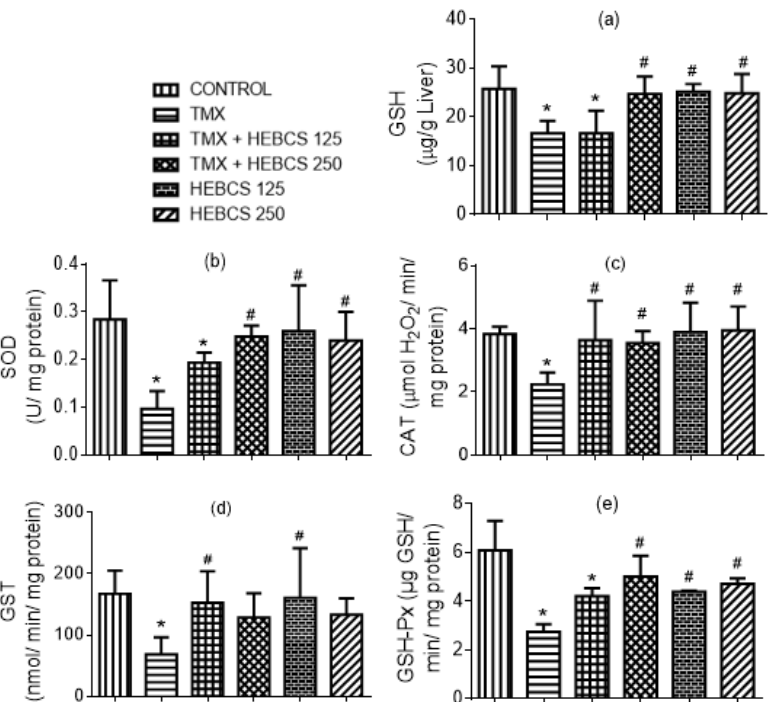
Figure 11. Ameliorative effect of HEBCS against TMX-induced decrease in ( a ) hepatic GSH level; ( b ) hepatic SOD activity; ( c ) hepatic CAT activity; ( d ) hepatic GST activity; and ( e ) hepatic GSH-Px activity in rats. Data are presented as mean ± SD ( n = 6). * p < 0.05 Control versus other groups; # p < 0.05 TMX versus HEBCS groups. GSH: reduced glutathione; SOD: superoxide dismutase; CAT: catalase; GST: glutathione S-transferase; GSH-Px: glutathione peroxidase; TMX: Tamoxifen; HEBCS 125 and 250: Hydroethanolic Extract of Buchholzia coriacea Seeds, 125 and 250 mg/kg body weight.